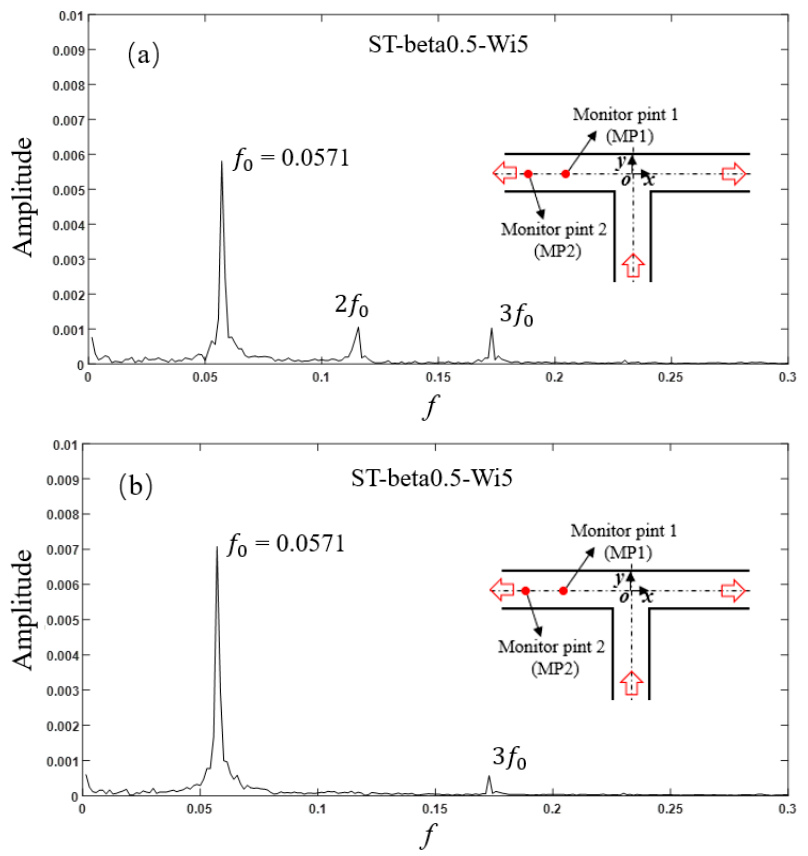
Figure 6. Amplitude spectrum of axial velocity fluctuation at ( a ) MP1 and ( b ) MP2 for the ST structure with β = 0.5, Wi = 5.